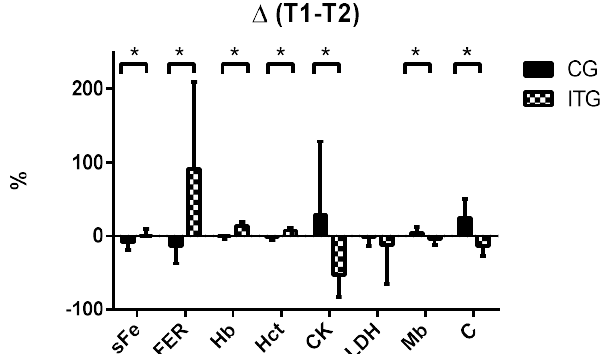
Figure 3. Percentages of change observed during the study in iron-related parameters, muscle damage markers and cortisol in the control group (CG) and the iron supplemented group (ITG). Data are expressed as mean ± standard deviation. sFe: Serum iron; FER: Serum ferritin; Hb: Hemoglobin; Hct: Hematocrit; CK: Creatine Kinase; LDH: Lactate dehydrogenase; Mb: Myoglobin; C: Cortisol. *: Significantly different between groups, p < 0.05.